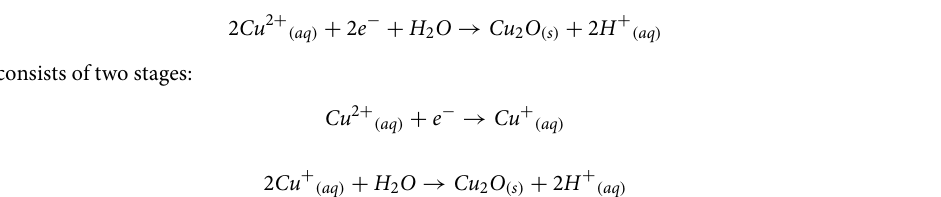
Figure 12. SEM images of A7 sample (ECD deposition time of 600 s, CuSO 4 concentration of 1 mM): cross section ( a ), cross section with elements distribution ( b ), single element distribution ( c – i ) including copper ( c ), iron ( d ), chromium ( e ), oxygen ( f ), carbon ( g ), nickel ( h ) and gold ( i